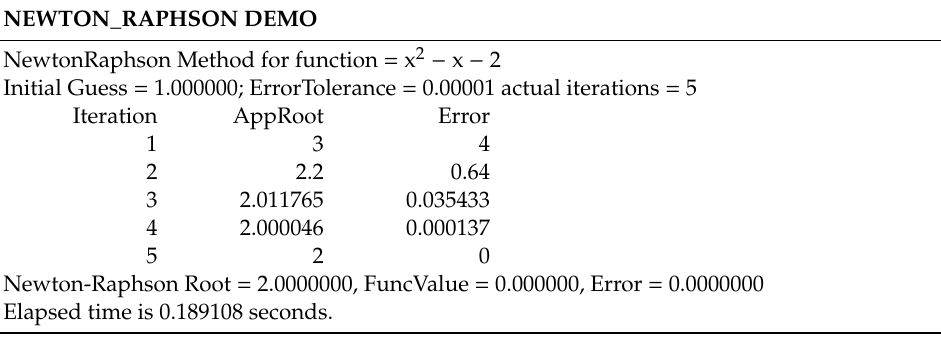
Table 6. Newton–Raphson algorithm, iterations, AppRoot and error.